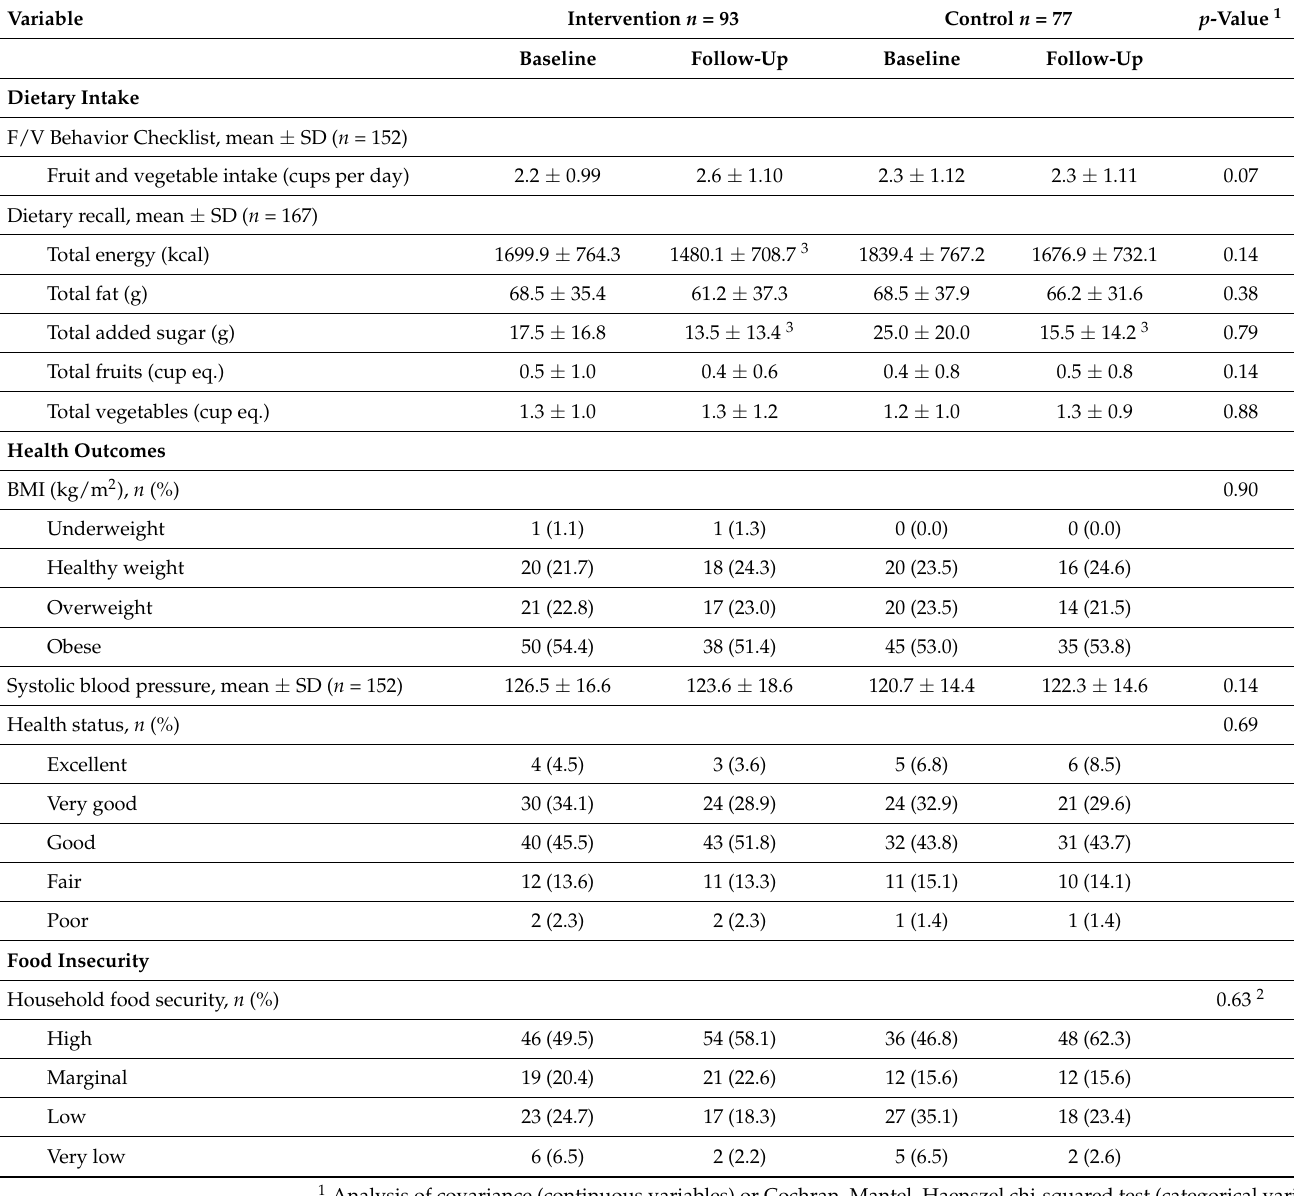
Table 3. Differences in baseline and follow-up measurements of outcomes for parents in the FRESH study.